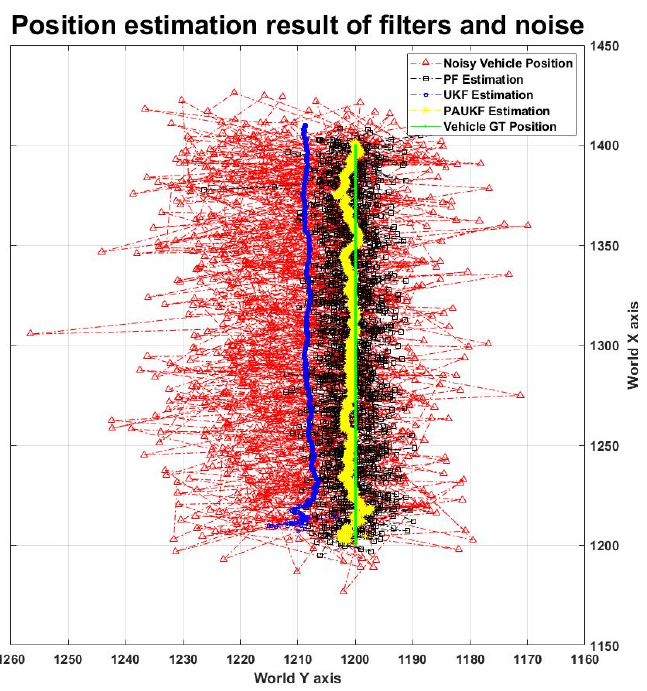
Figure 5. Position estimation result of the filters. Table 5. RMSE of filters in di ff erent conditions (unit: m). With Gaussian